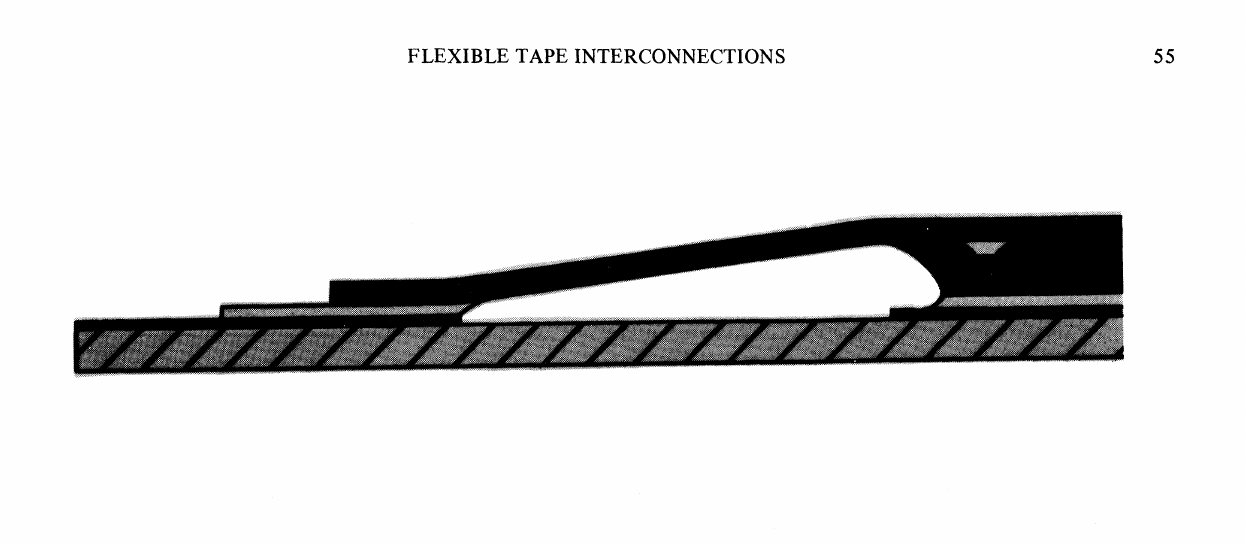
FIGURE 3 Schematic drawing of IC-on-tape mounted onto thickfilm. The chip (right side) is connected in two ways to the substrate, the outerlead bonding (left side) and the chip-backbonding (right side). 3.